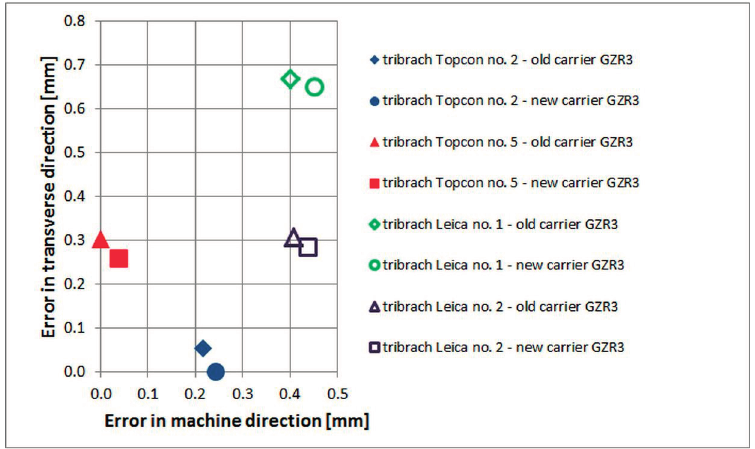
Figure 6. Comparison of the tribrachs and carriers centers on one forced